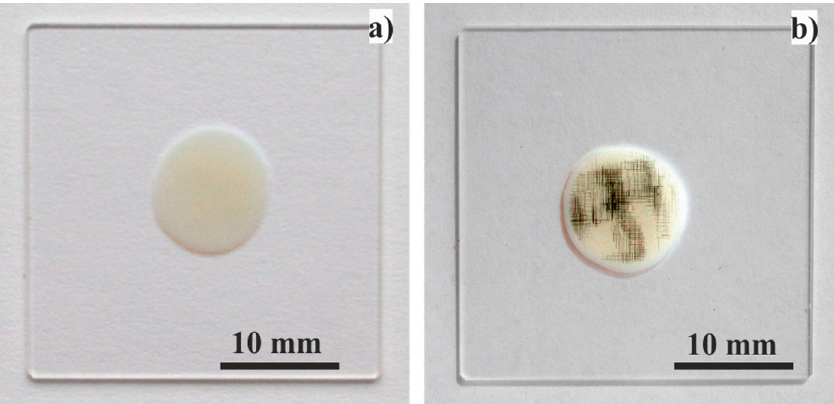
Figure 1. ( a ) Image of high-pressure high-temperature (HP-HT) nanodiamond film with a thickness of 20 µ m on a quartz substrate before laser irradiation; ( b ) image of 20- µ m-thick HP-HT nanodiamond film with a thickness of 20 µ m on a quartz substrate after laser irradiation where a laser beam scanned